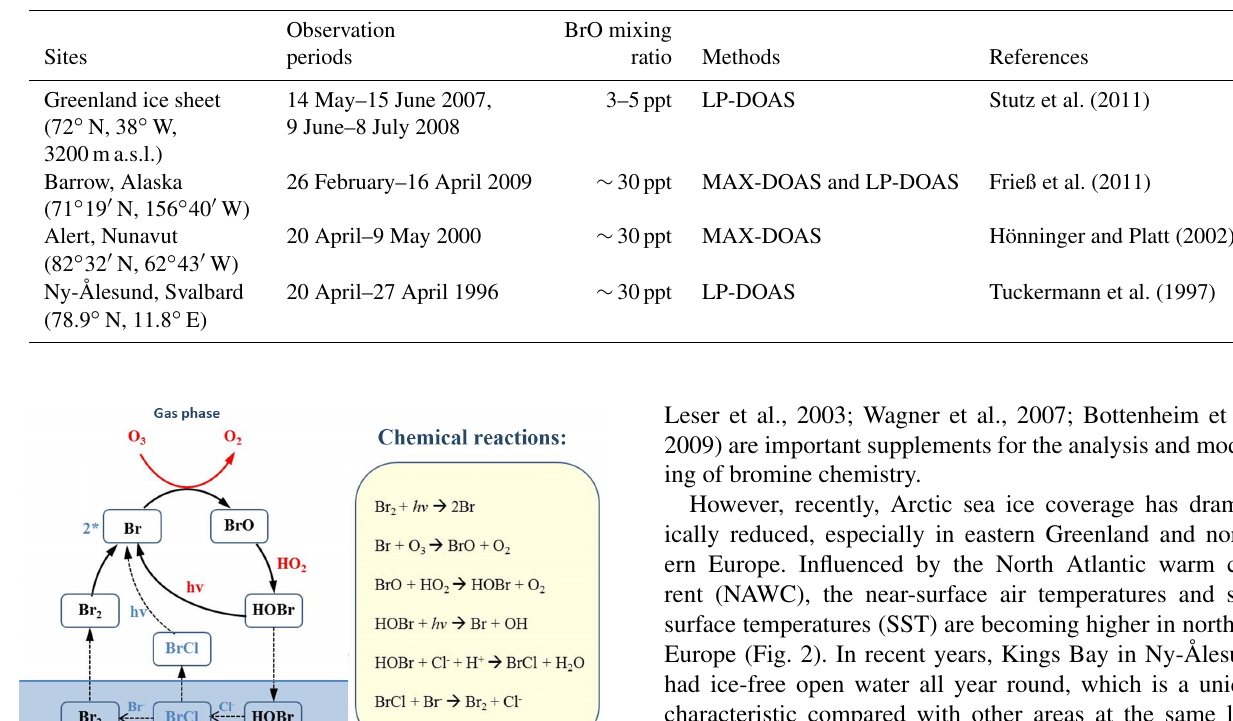
Table 1. Comparisons of BrO mixing ratios at four main Arctic observation sites.